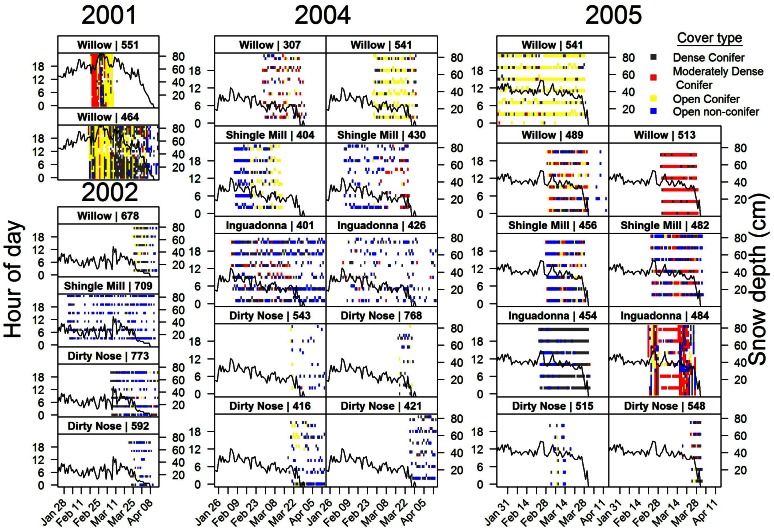
Availability (versus time) of dense (≥70% canopy closure, left panel) and moderately dense (40% ≤×<70% canopy closure, right panel) conifer cover for each of four study sites, north-central Minnesota, 1991–2005.First-year baseline was dependent on the year the site was incorporated into the study and habitat quantified.